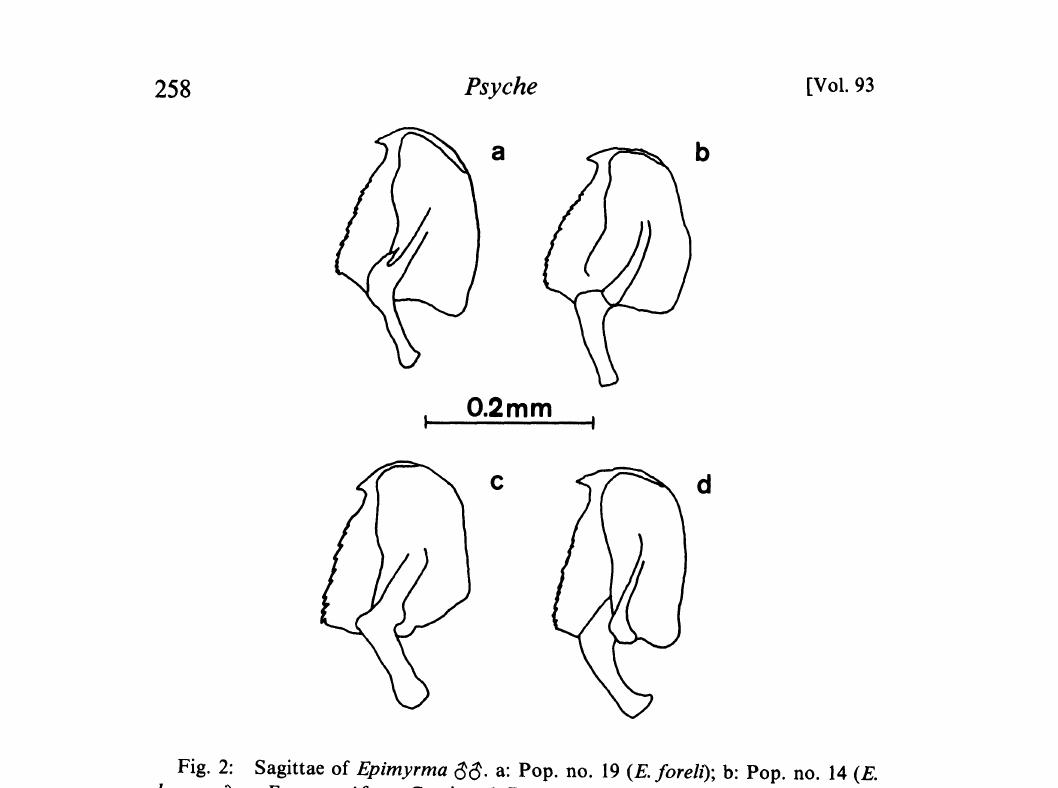
Fig. 2: Sagittae of Epimyrma cc. a: Pop. no. 19 (E. foreli); b: Pop. no. 14 (E. kraussei); c: E. ravouxi from Corsica: d: Pop. no. 5a (E. vandeli). mounds were made of the subgenital plate, the sagittae, and